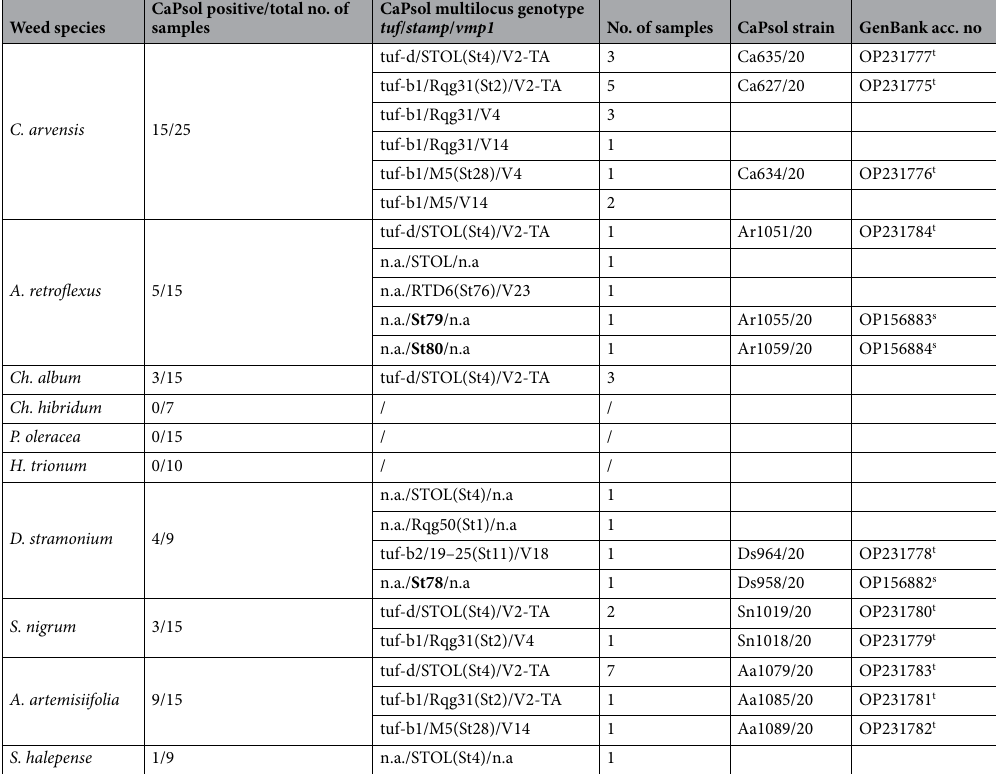
Table 1. CaPsol multilocus genotypes detected in weeds in sugar beet plot-1 during the 2020 epidemic RTD occurrence. The “St” stamp sequence variants, corresponding to the original stamp genotype designation 28,29 , are provided in parentheses next to the first mention of a particular genotype in a given host plant. Newly detected stamp genotypes are labelled in bold. Affiliated “St” stamp sequence variants are elaborated in Supplementary Table S1; not amplified (n.a.); stamp sequence ( s ); tuf sequence ( t